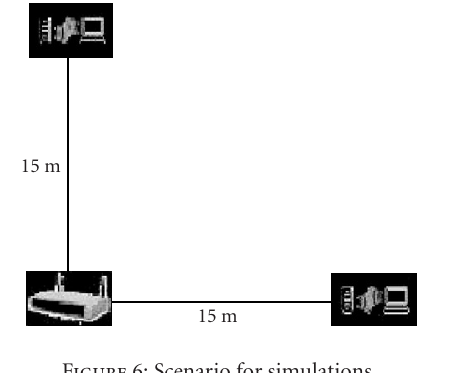
Figure 6: Scenario for